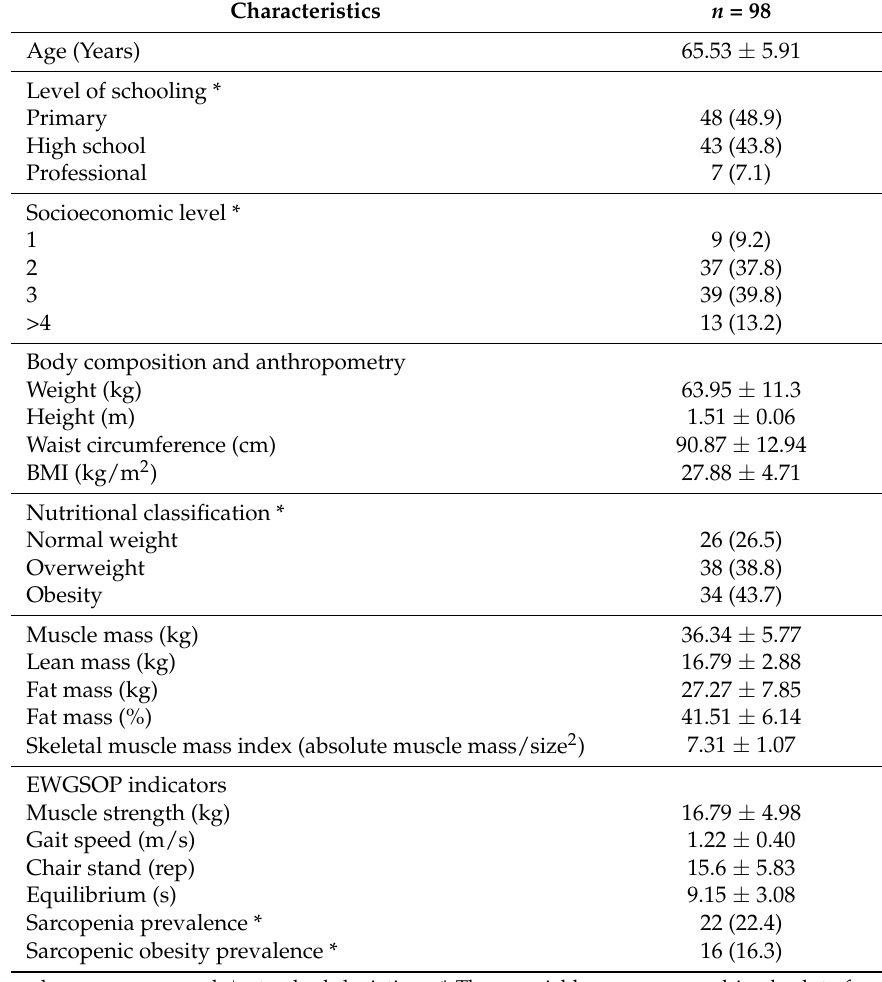
Table 2. Clinical characteristics of the population women survivors of breast cancer, Bogot á ,